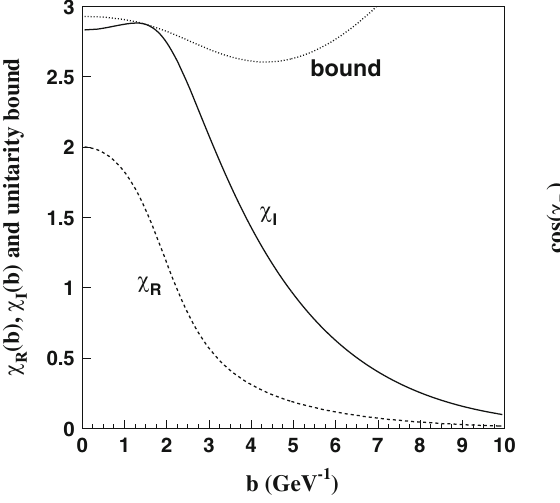
small b , with χ R ( 0 ) = 2 . 0010 , and cos χ R ( 0 ) = − 0 . 4170; at b = b root = 1 . 4739 GeV − 1 , we have χ R ( b root ) = π/ 2 and cos χ R ( b root ) =